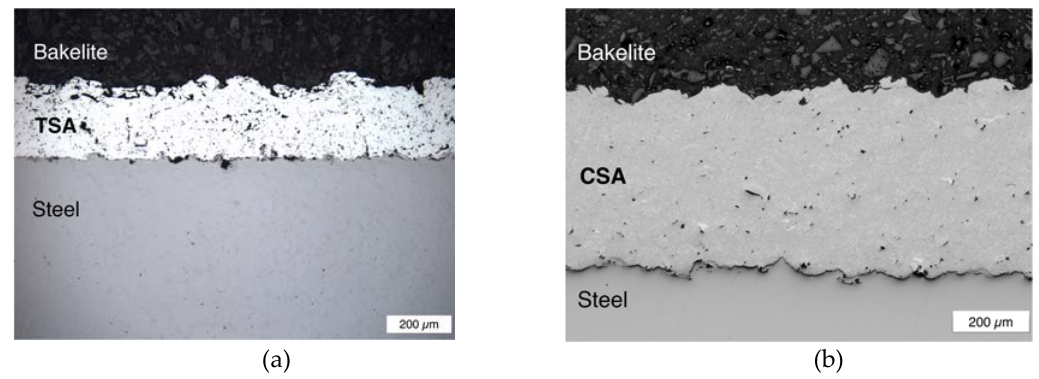
Figure 3. Cross ‐ section of arc ‐ sprayed Al coating (a) and cold ‐ sprayed Al–12%Si coating (b) on steel. 101 Figure 3. Cross-section of arc-sprayed Al coating ( a ) and cold-sprayed Al–12%Si coating ( b ) on